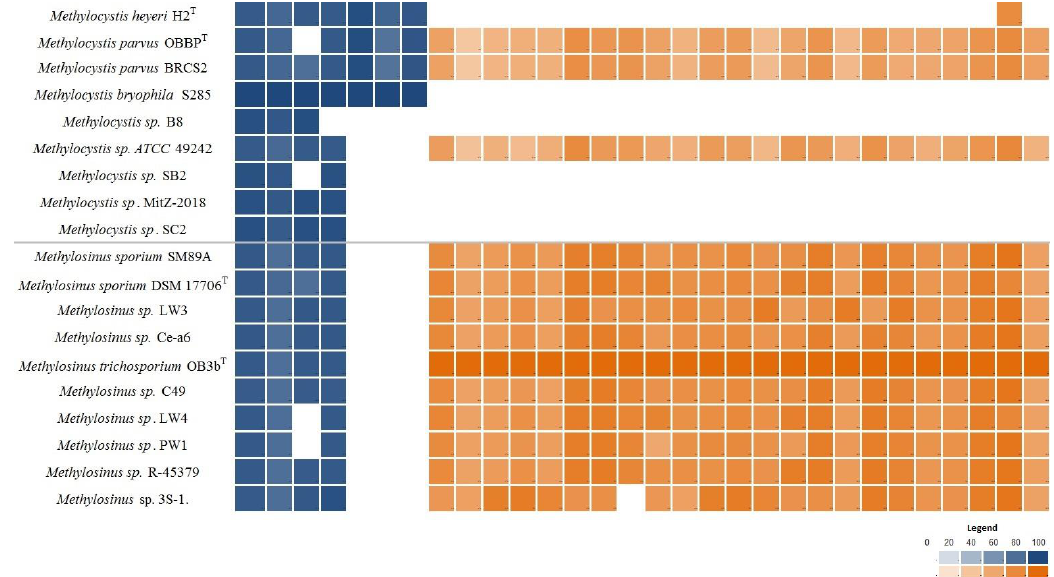
Figure 5. Heatmap displaying distribution of nitrogenase-encoding genes (shown in blue) and genes encoding flagella biosynthesis (shown in orange) in the genomes of Methylocystis and Methylosinus species. The color intensity reflects the percent identity shared with the reference proteins: nitrogenase complex proteins from Mc. bryophila S285 and motility-related genes from Ms. trichosporium OB3b T .